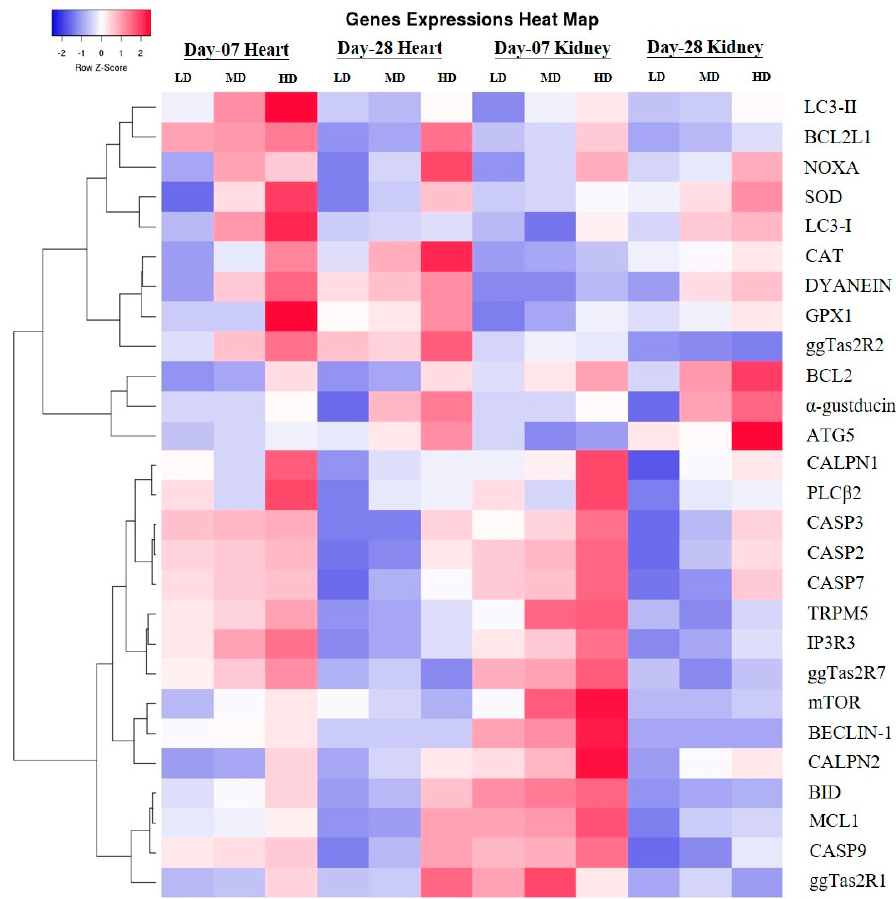
Figure 13. Heat map of expression profiles (bitter taste, downstream signaling effectors, apoptosis, autophagy and antioxidant genes) in supplementation with three different doses of DB in two stages (day-07 and day-28) in the heart and kidney of chicken.